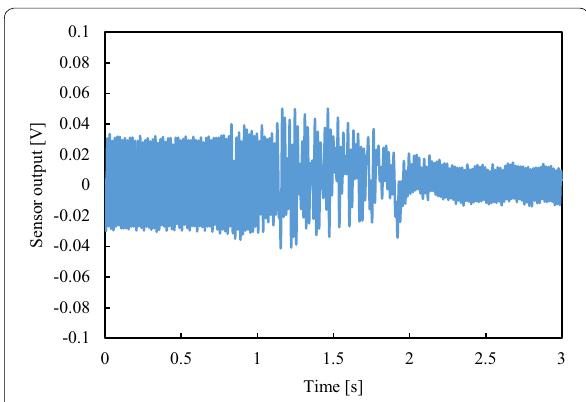
Fig. 15 Filtered sensor output in blood vessel model No. 2 (convexity interval: 2.0 mm, insertion velocity: 30